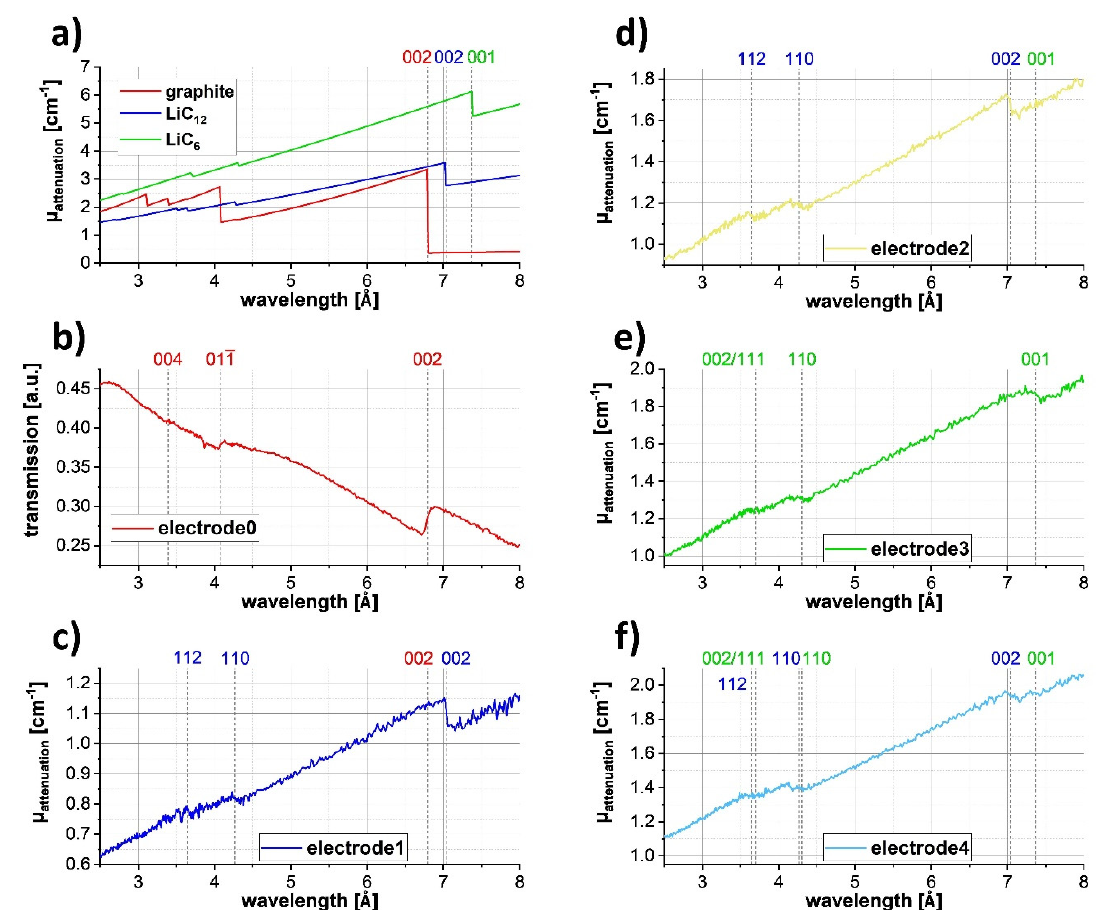
Figure 5. Identification of crystallographic lithiation phases using Bragg edges. ( a ) Calculated attenuation spectra for graphite (red), LiC 12 (blue) and LiC 6 phases (green). The dashed vertical lines indicate Bragg edge positions. ( b ) Transmission spectrum from the radiograph of the 12 mm diameter pristine DIT graphite electrode, identifying the graphite phase with dominant (002), (01-1) and (004) Bragg edges (mixed with the PFA signal). ( c ) Reconstructed wavelength-resolved attenuation coe ffi cients of mixed graphite and LiC 12 phases in the 33% lithiated electrode-1; ( d ) LiC 12 for electrode-2 at 66 % lithiation; ( e ) LiC 6 for electrode-3 at 100% lithiation; ( f ) mixed LiC 12 and LiC 6 at 70% lithiation in electrode-4. For each 6 mm diameter electrode, the attenuation curve was extracted for a representative horizontal slice and averaged from a region of interest within the slice.